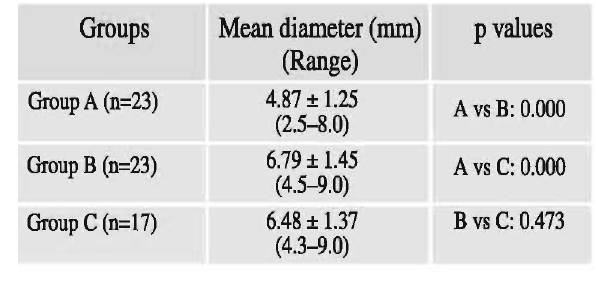
Table I: Mean diameters of the right superior cerebellar